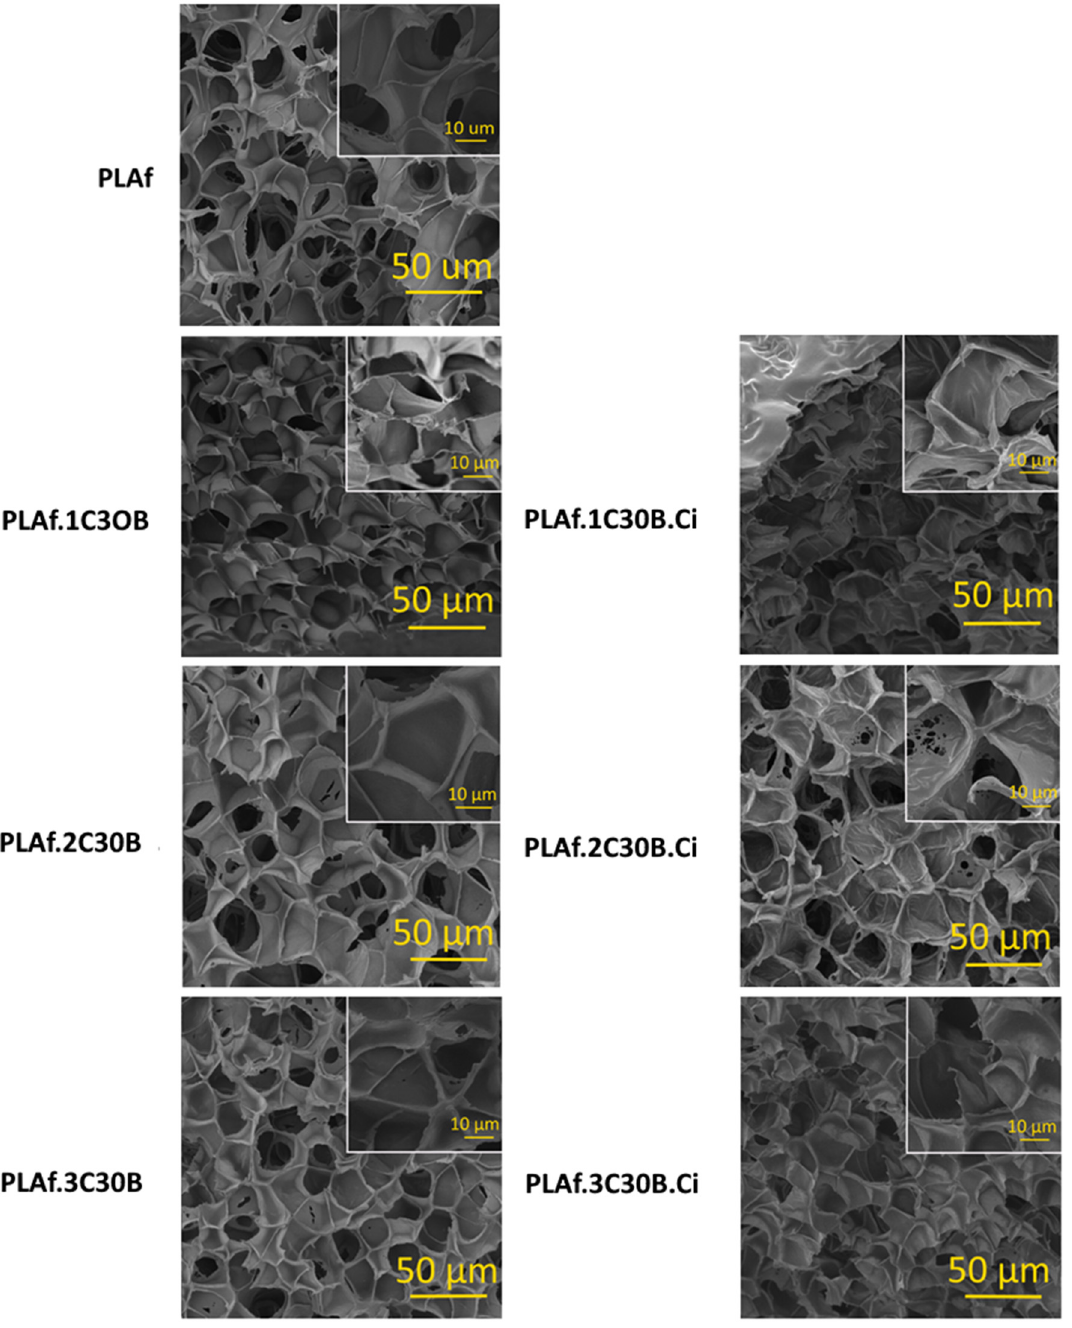
Figure 2. SEM micrographs of developed PLA foams obtained by foaming with scCO 2 and impreg- nation.